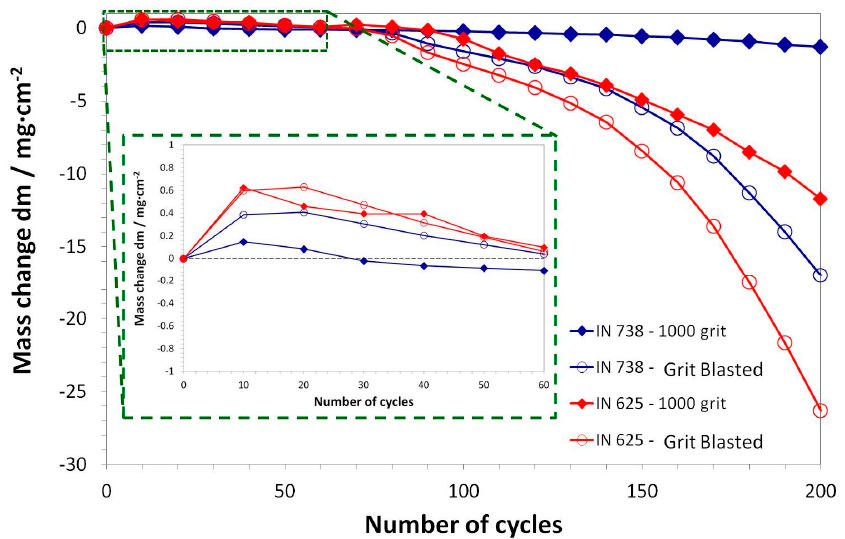
Figure 11. Mass changes plot obtained during thermal shocking test with cycles of 2 h heating and 15 min cooling, with pressurized air at 1120 °C in the air measured on aluminide coatings grown on IN 625 (red curves) and IN 738 (blue curves) with ground (fulfilled rectangular marks) and grit-blasted (circular open marks) surfaces.